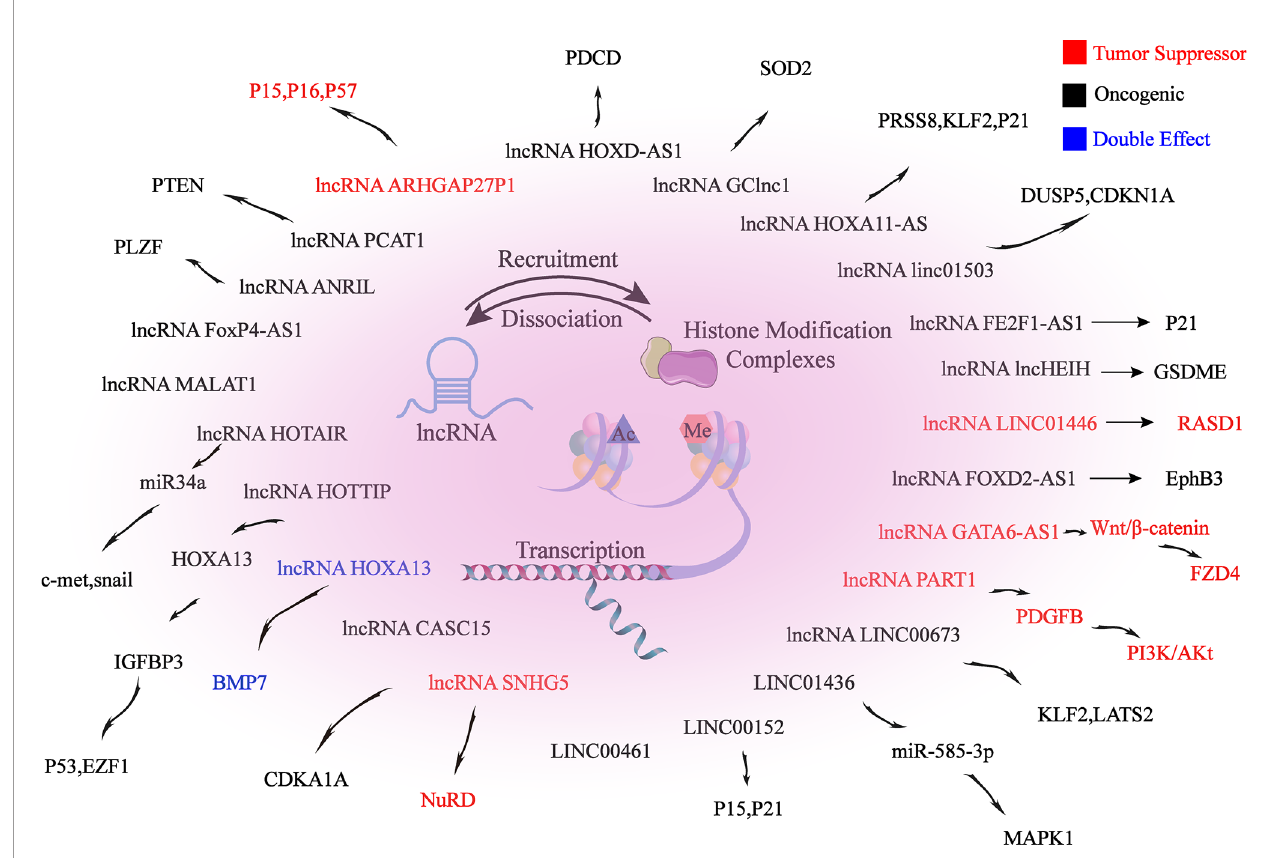
FIGURE 2 | lncRNAs mediate histone modi fi cations of target genes. lncRNAs induce changes in promoter histone modi fi cation patterns by recruiting histone modi fi cation complexes to target gene promoter-associated binding sites, thereby epigenetically regulating target gene expression, which ultimately alters the biological behaviors of